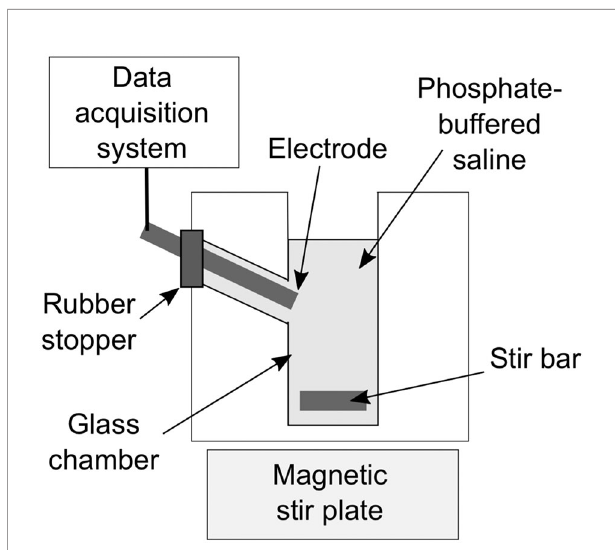
FIGURE 2 | Schematic of the experimental set-up with the amperometric microelectrode sensor that was used to measure the NO dose.